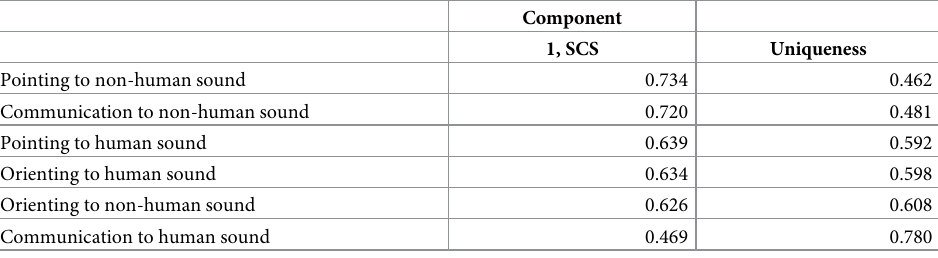
Table 2. Constrained Varimax solution for socio-cognitive behaviors principal component analysis (N = 91).